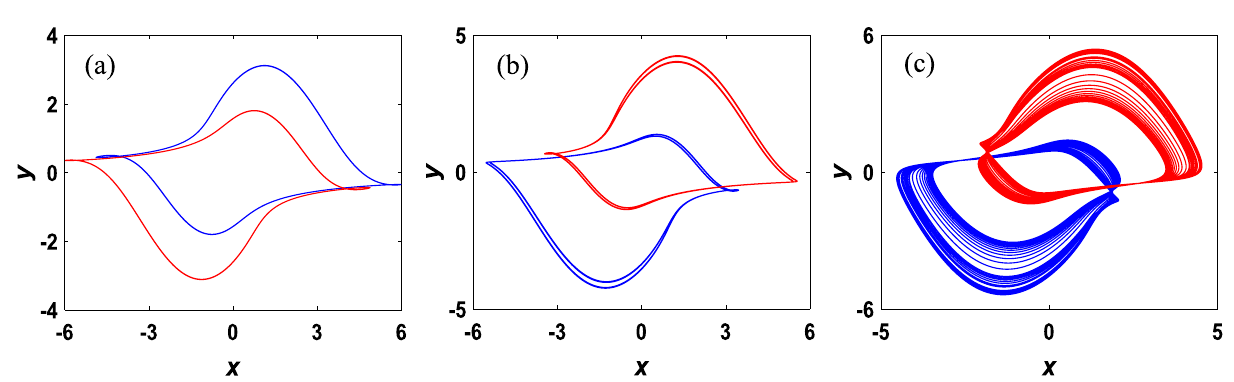
Figure 6. A pair of symmetry singular attractors of the system (3) with parameter ν condition ( 0.1, 2, 0.1). ± ±